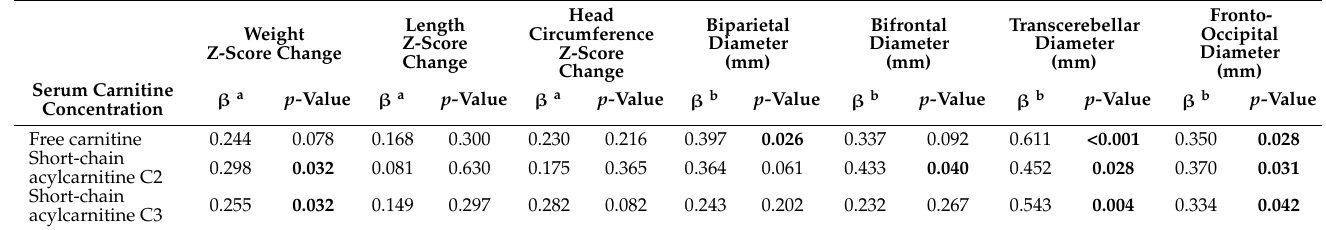
a Linear regression model was adjusted for sex, birthweight Z-score, and gestational weeks at birth,